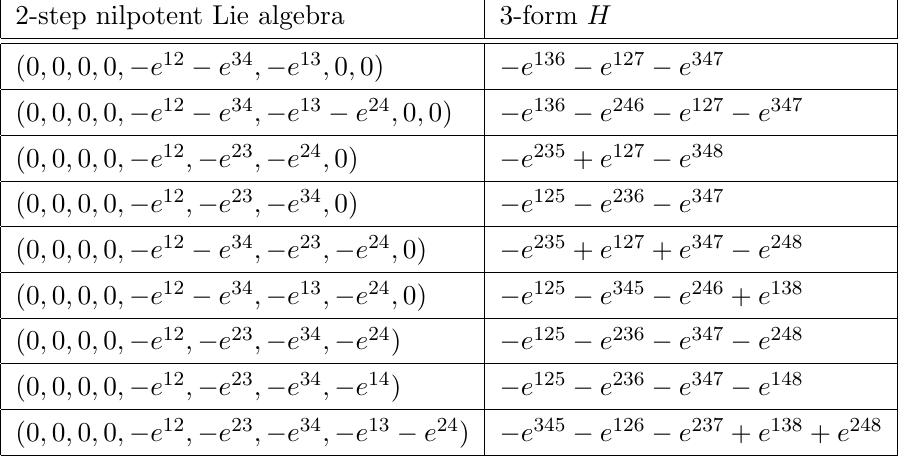
Table 3 . 8-dimensional 2-step nilpotent Lie algebra and the corresponding 3-form H . 4 T -duality on